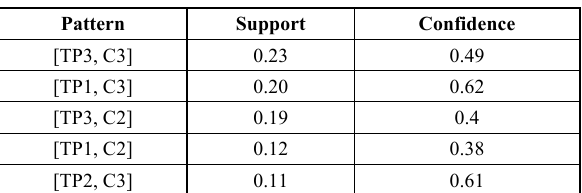
TABLE III. U SAGE P ATTERNS OF A